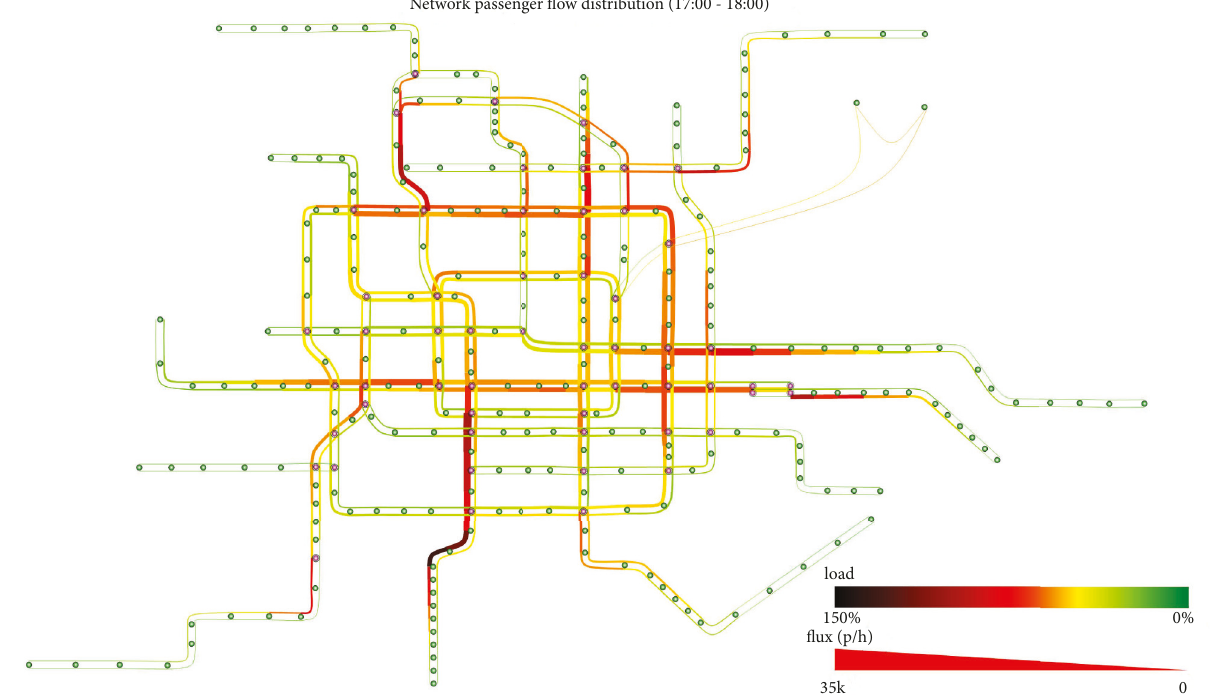
Figure 8: Distribution of URT network passenger flow during peak